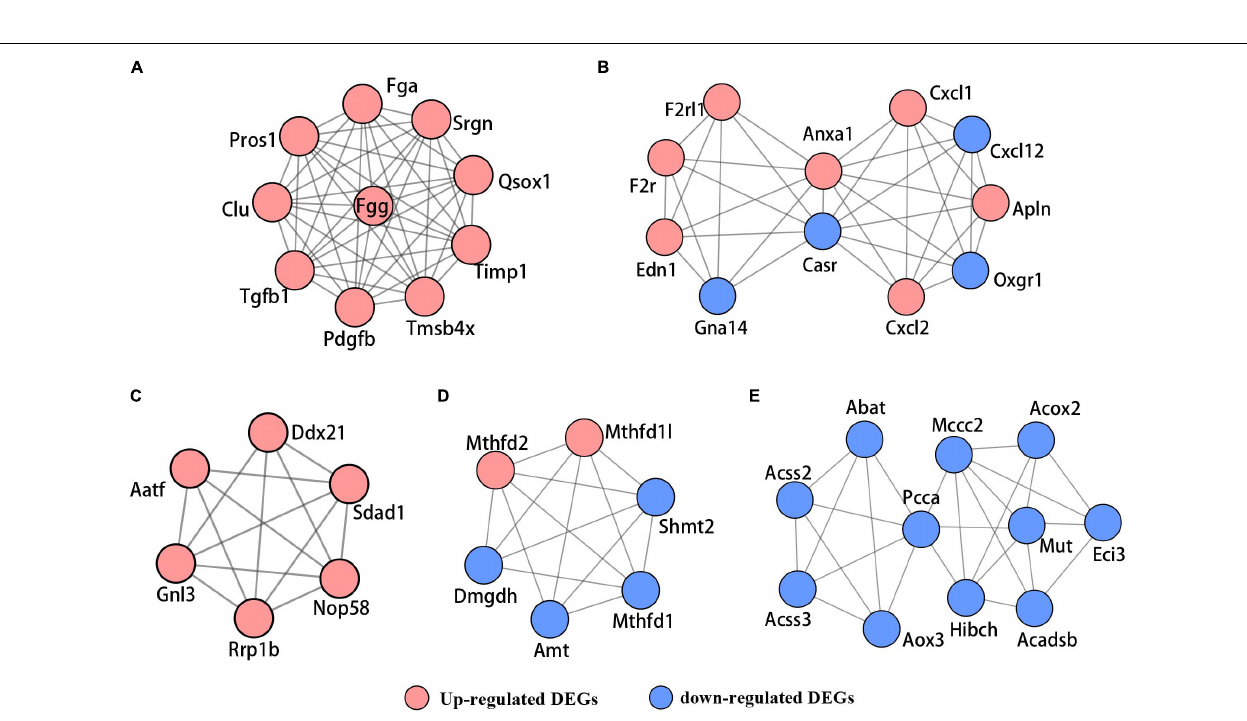
FIGURE 5 | The PPI network of five significant modules selected by MCODE. (A) Module 1, (B) module 2, (C) module 3, (D ) module 4, and (E) module 5. Red nodes represent upregulated genes; blue nodes stand for downregulated genes.